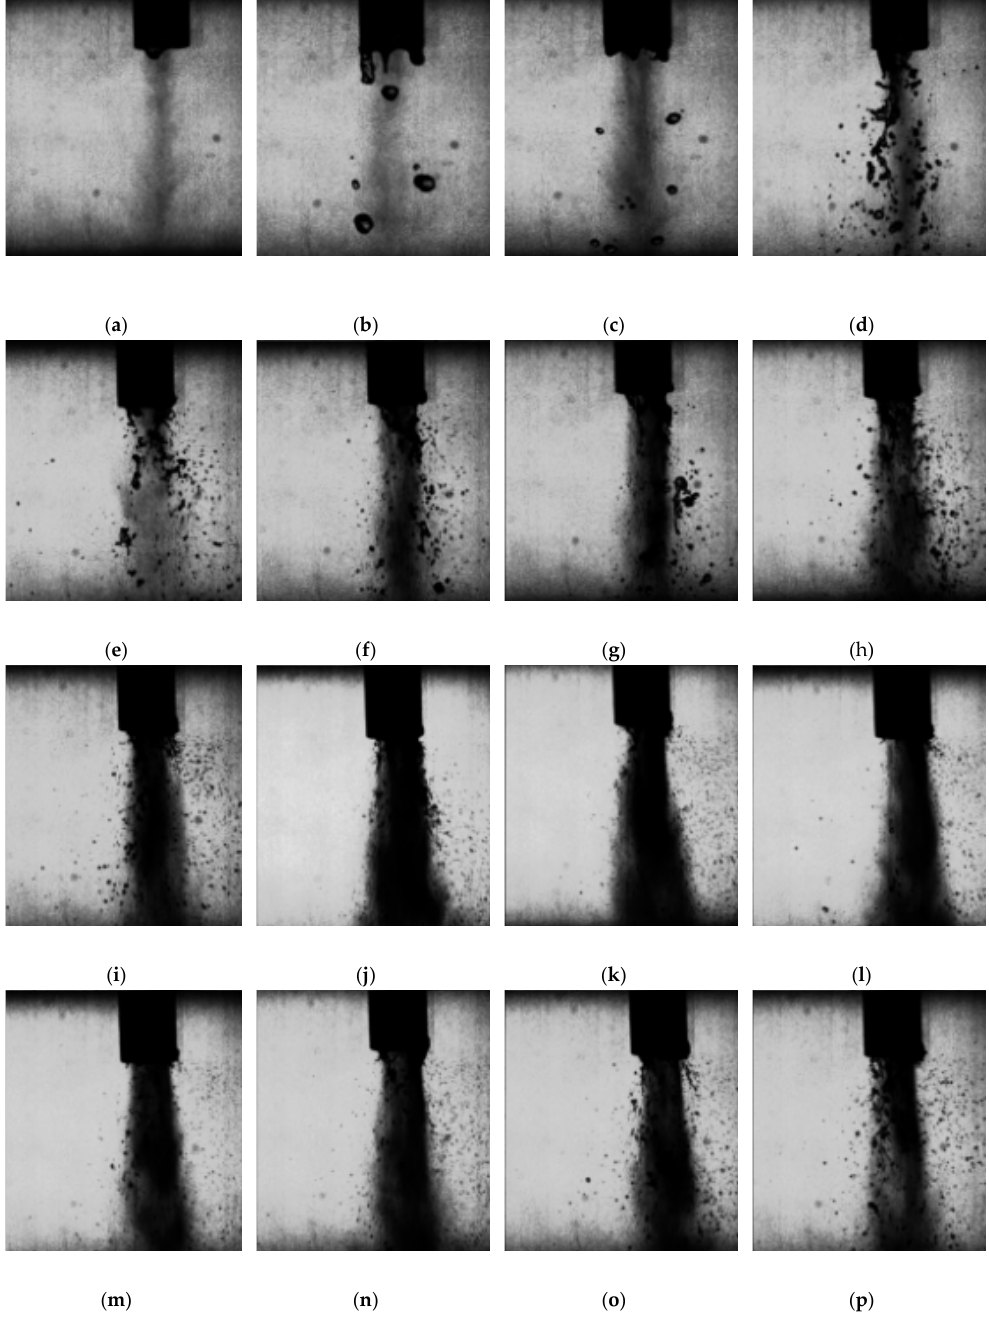
Figure 9. Evolution of atomization for ejector with different primary flow pressures. ( a ) 0 bar; ( b ) 0.4 bar; ( c ) 0.8 bar; ( d ) 1.2 bar; ( e ) 1.6 bar; ( f ) 2.0 bar; ( g ) 2.4 bar; ( h ) 2.8 bar; ( i ) 3.2 bar; ( j ) 3.6 bar; ( k ) 4.0 bar; ( l ) 4.4 bar; ( m ) 4.8 bar; ( n ) 5.2 bar; ( o ) 5.6 bar; ( p ) 6.0 bar.